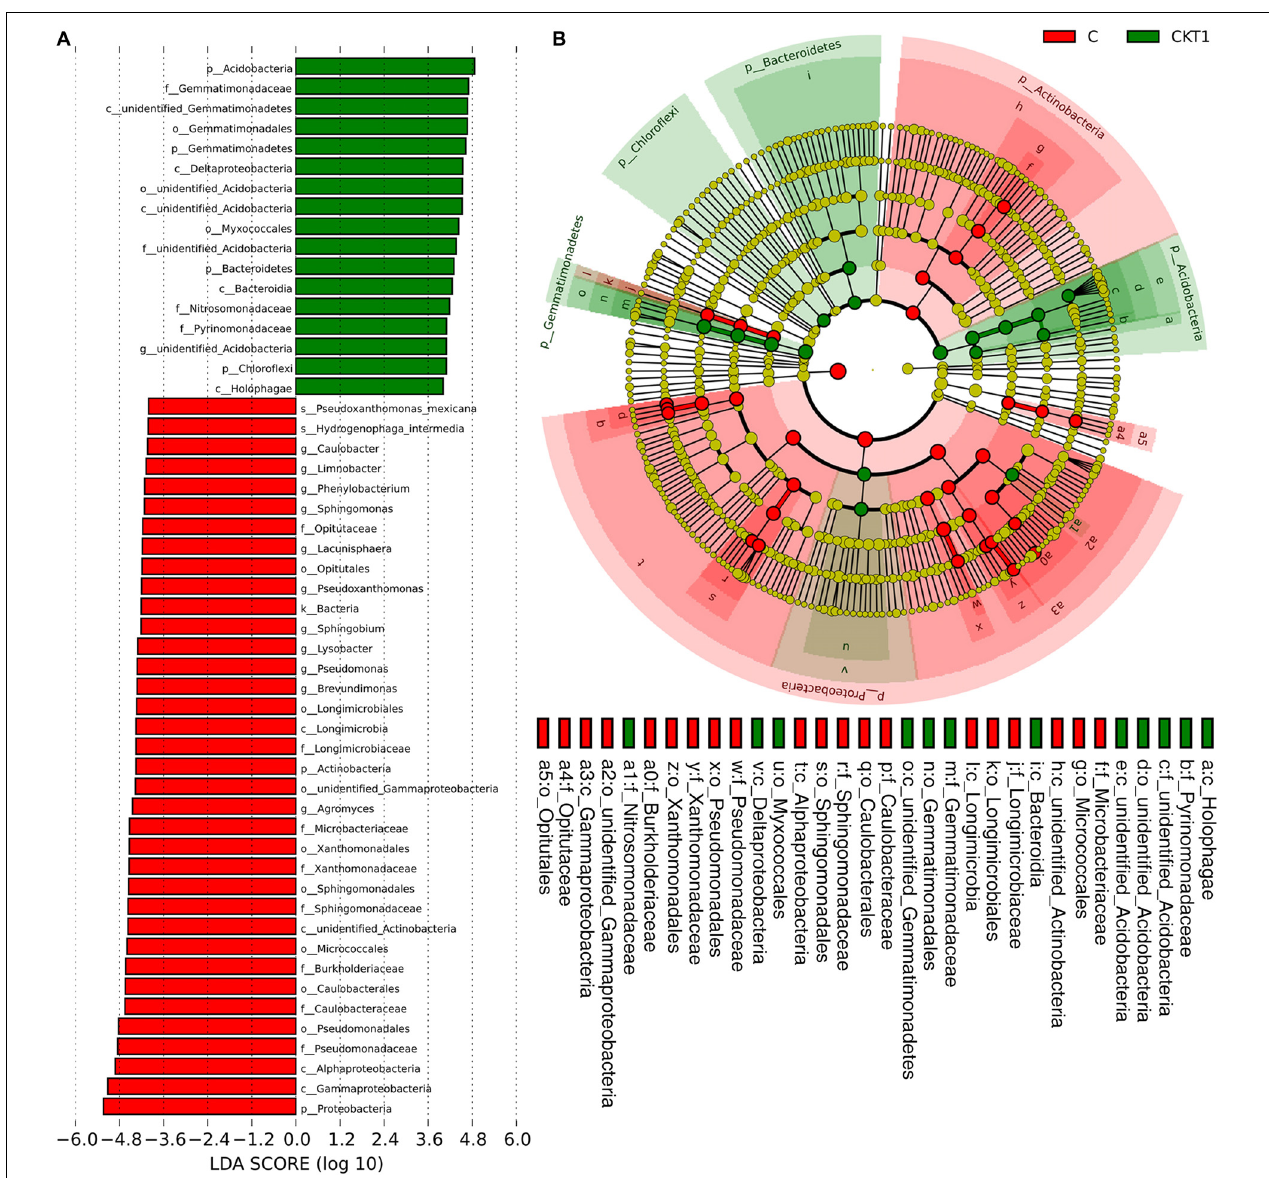
FIGURE 10 | Linear discriminant analysis identified the differentially abundant bacterial taxa between soils amended with and without catalpol. (A) Bacterial taxa meeting a linear discriminant analysis (LDA) significant threshold > 4 are presented. (B) Cladogram of control and catalpol treatments. CKT1 represents soil control without catalpol. C represents soil amended with catalpol for 60